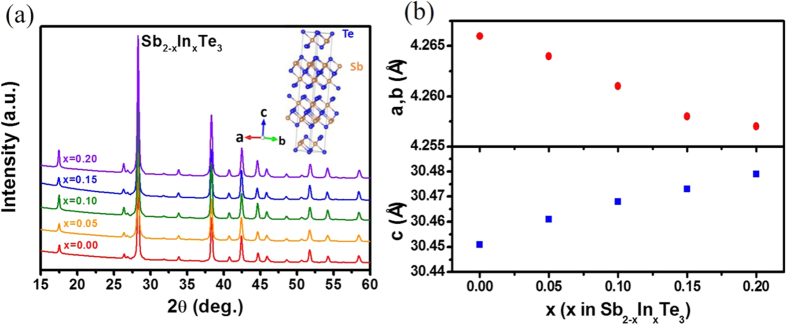
(a) Powder XRD patterns of Sb2−xInxTe3 (x = 0–0.2) samples, (b) lattice parameters as a function of x at 300 K. The inset of (a) shows the crystal structure of Sb2Te3.